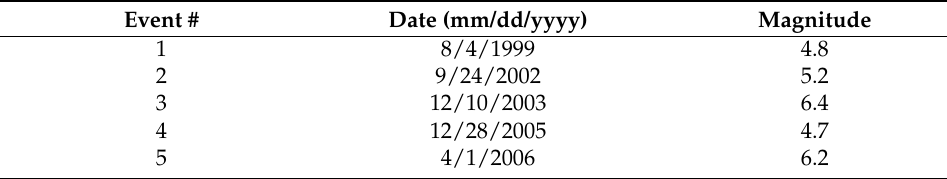
Figure 8. Sensor locations at TFB building. Table 6. Earthquake events recorded by the sensors of TFB